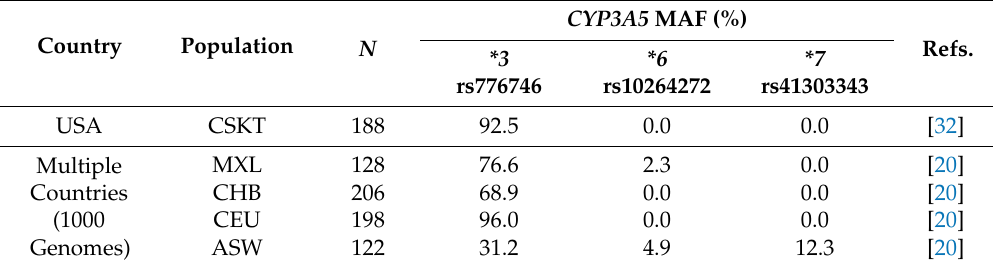
Table 12. Comparison of CYP3A5 allele frequencies Indigenous North American populations to global populations from the 1000 Genomes Project [20]. N represents the number of alleles. Global populations are abbreviated as follows: African Ancestry in Southwest US (ASW); Utah residents with Northern and Western European ancestry (CEU); Han Chinese in Beijing, China (CHB); Mexican Ancestry in Los Angeles, California